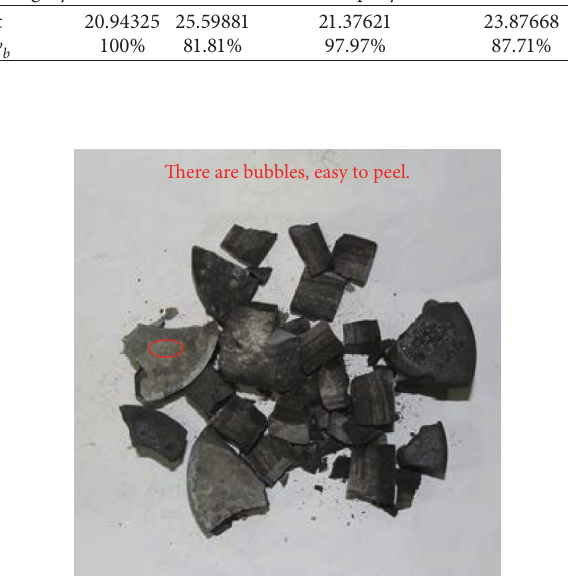
Figure 9: Cement slurry filling.